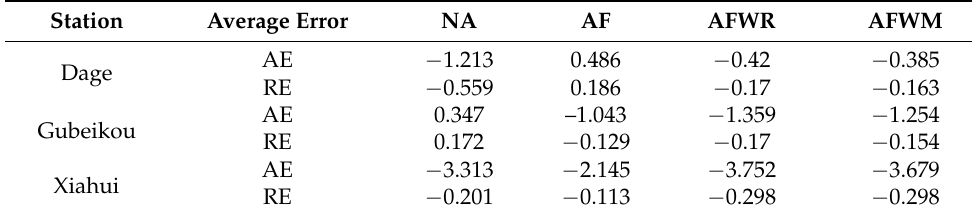
Table 4. Average error values of the four assimilation settings for the three stations.